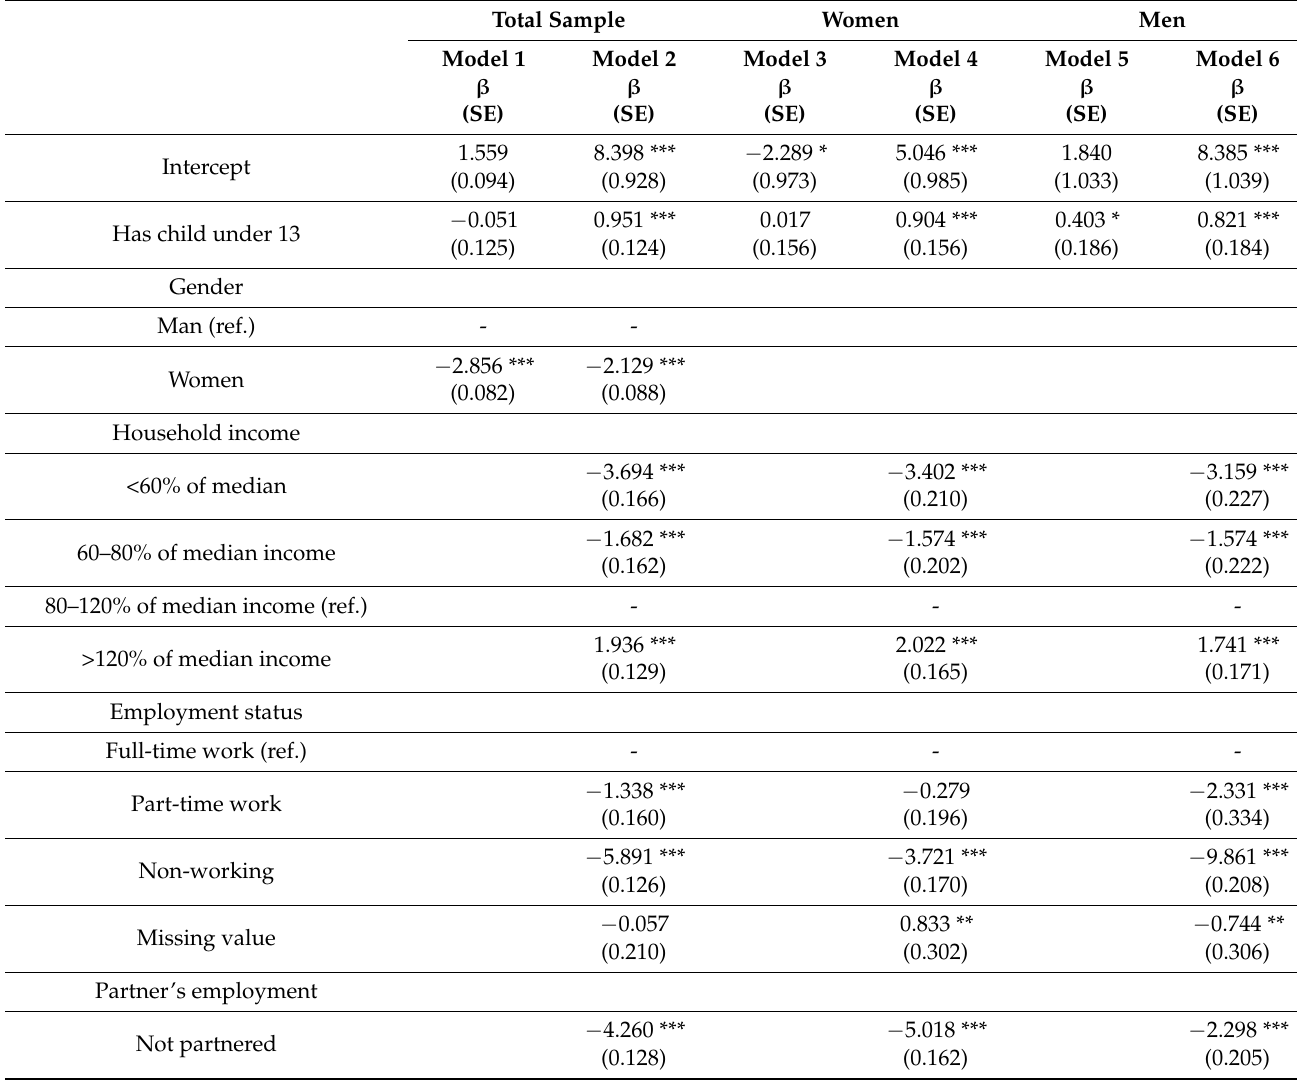
Table 3. Multilevel regression of mental health on parenthood—main effects at the individual level; total sample, women, and men